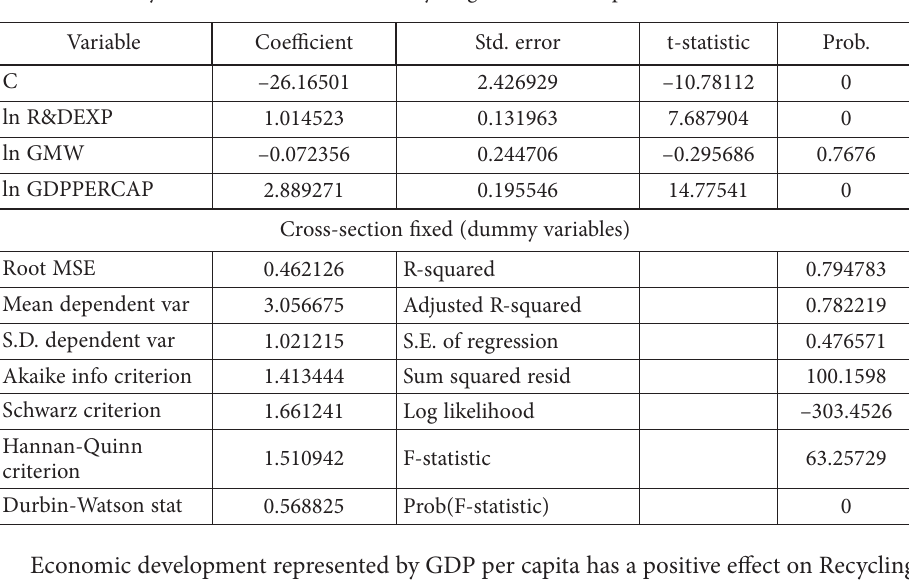
Table 4. Summary of FEM-Determinants of recycling rate of municipal waste